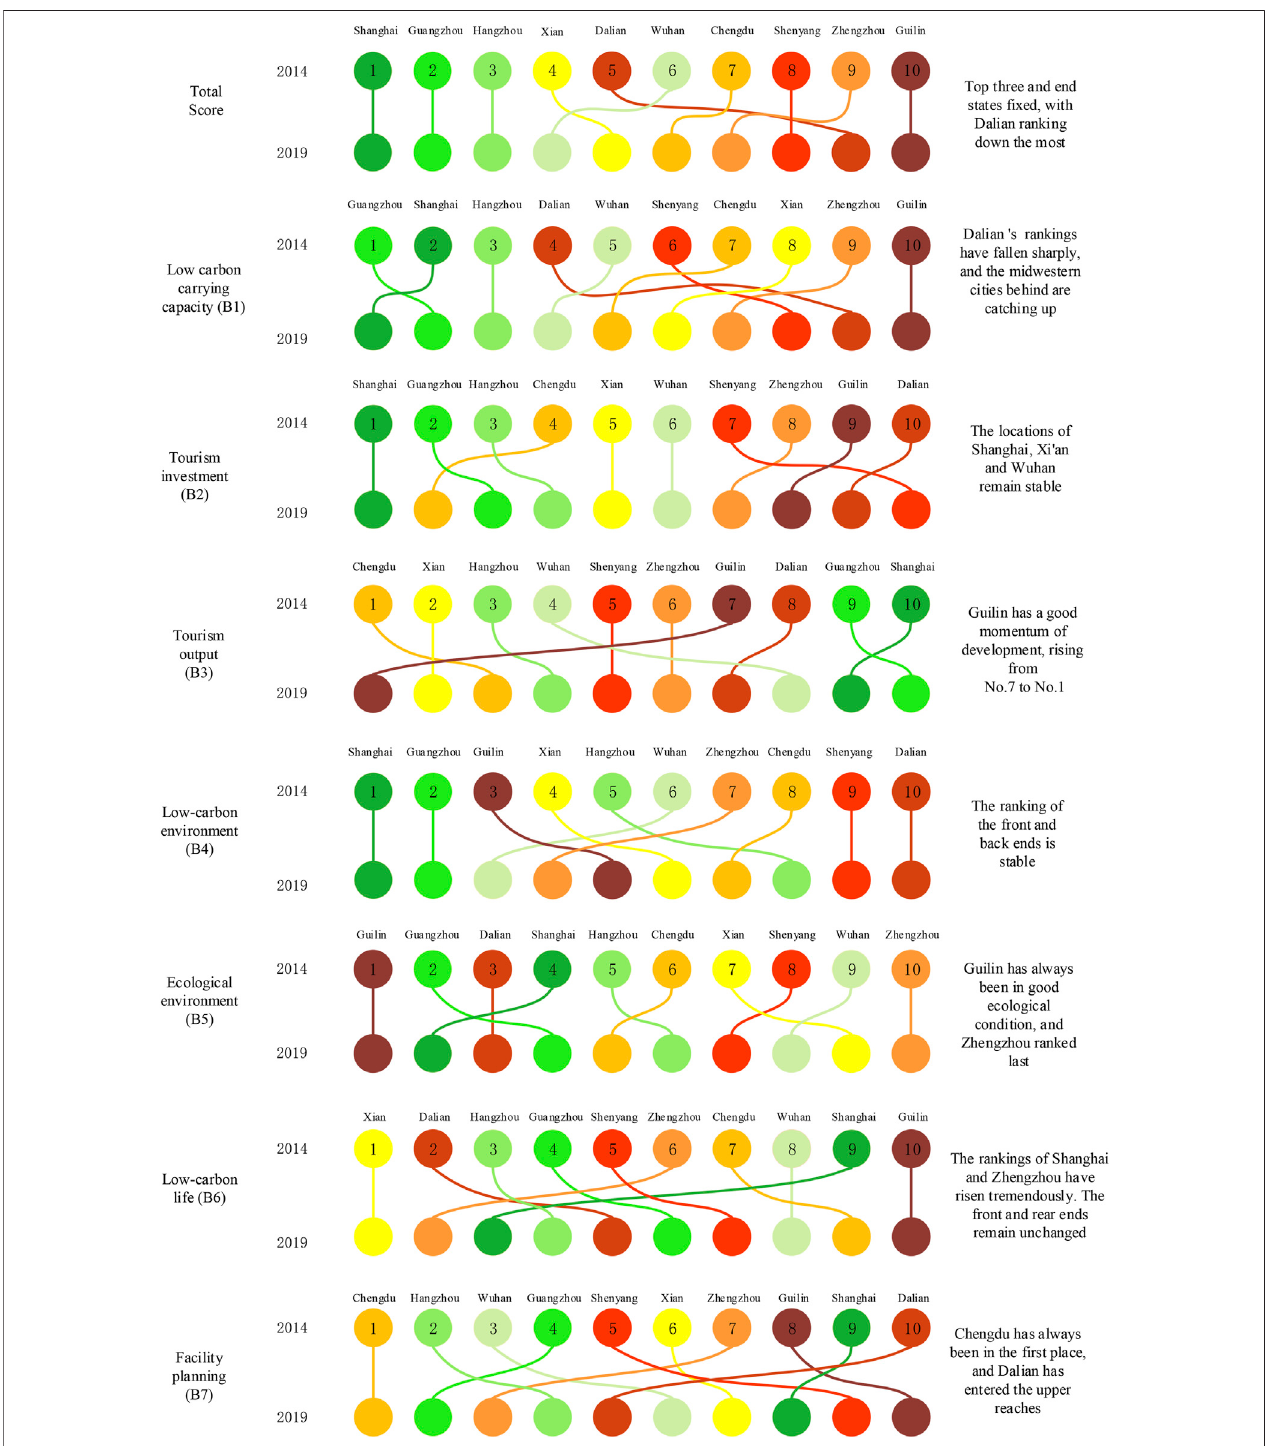
FIGURE 4 | Changes in the ranking of cities ’ low-carbon tourism